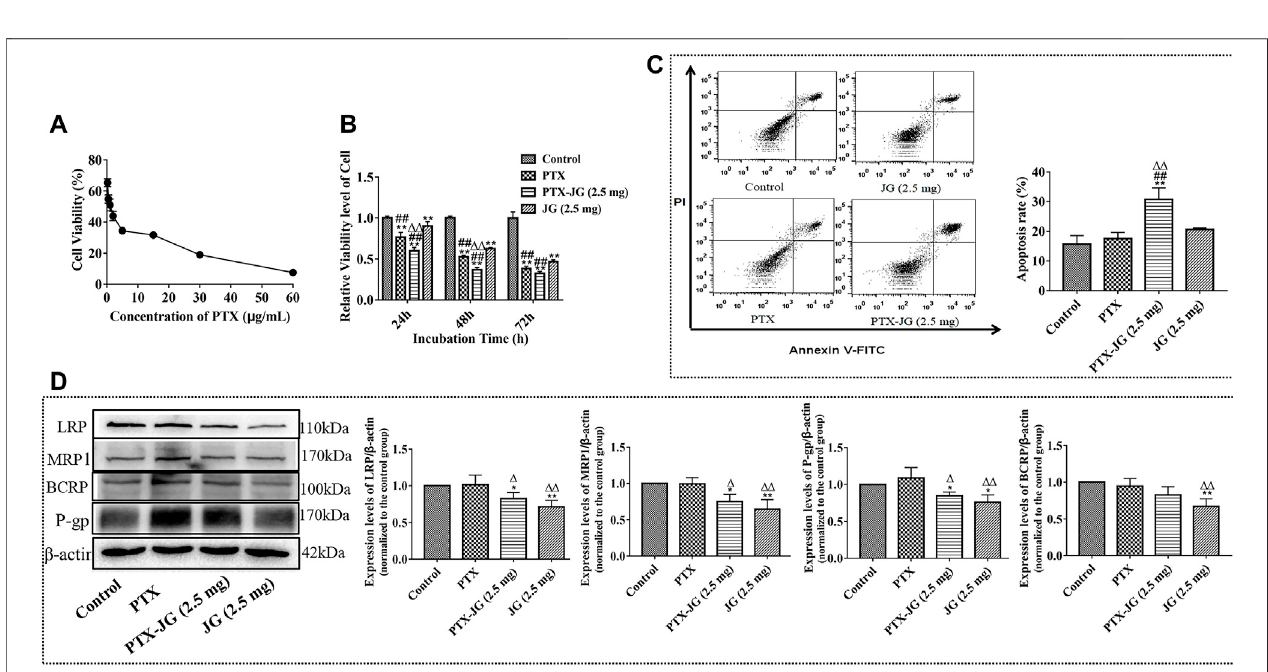
FIGURE 7 | Effects of the combination of JG and PTX on A549/PTX tumor cells. (A) : Cell viability of A549/PTX tumor cells after the combination of JG (2.5 mg/ml) withPTX(60, 30,15,5,2,1,0.5,0.25 μ g/ml)(n=6). (B) :EffectofthecombinationofJGwithPTXontheproliferationofA549/PTX tumorcellsat 24,48and 72 h(n=5). (C) :EffectsofthecombinationofJGwithPTXonapoptosisofA549/PTXtumorcellsusingAnnexinV-FITCandPIstaining(n=4). (D) :ProteinexpressionofLRP,MRP1, P-gp and BCRP of A549/PTX tumor cells were detected by Western blotting (n = 3). Values are expressed as the mean ± SD. * p < 0.05, ** p < 0.01, vs Control group; # p < 0.05, ## p < 0.01, vs JG group; △ p < 0.05, △△ p < 0.01, vs PTX group.